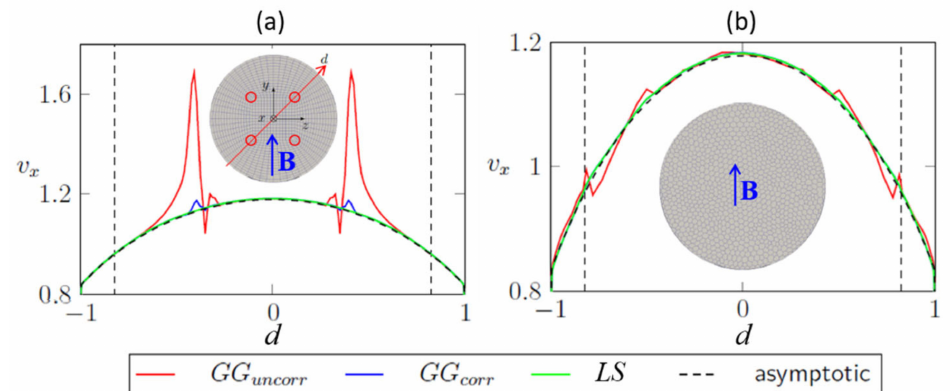
Figure 4. Influence of discretization schemes on MHD flow in an insulating pipe at Ha = 1000 [54]. Axial velocity profile along the diagonal marked in red in the sketch in ( a ), for two grid types, O-grid ( a ) and polyhedral mesh ( b ), and various discretization schemes for the electric potential gradient: Least-Squares ( LS ), skew-corrected Green–Gauss ( GG corr ), uncorrected Green–Gauss ( GG uncorr ). Verti- cal dashed lines indicate the boundary of the core grid. The black dashed curve shows the asymptotic solution according to Chang and Lundgren